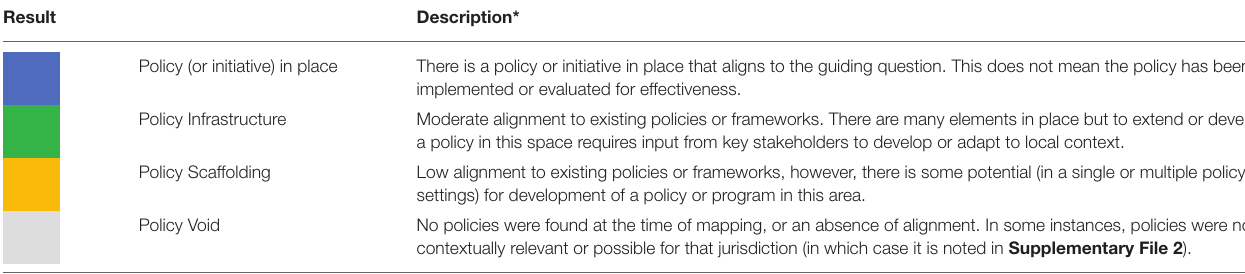
TABLE 1 | Ratings and descriptions for the policy mapping analysis.